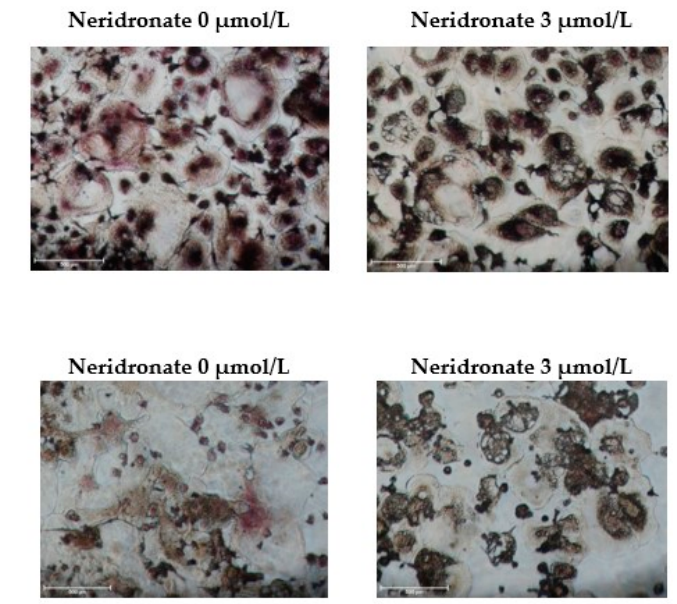
Figure 2. Multinucleated TRAP+ osteoclast cultures from a representative healthy donor and OI patient treated with MCSF and RANKL without or with 3 μ mol/L neridronate. Bars: 500 μ m